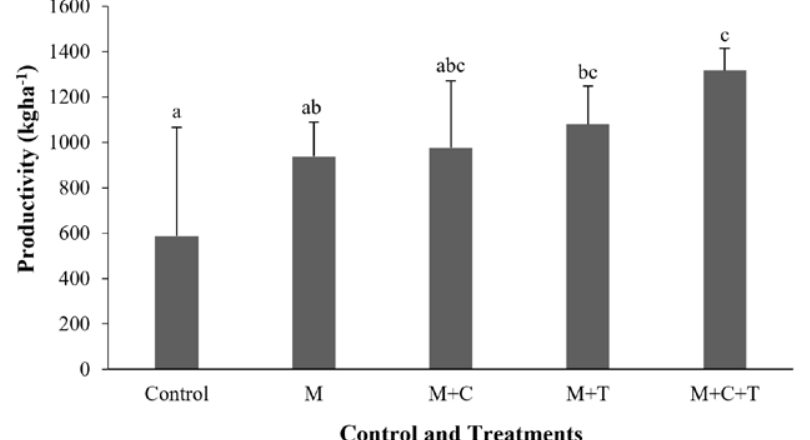
Fig. 2. Shallot productivity harvested at 63 days after treatment by mulch, mulch plus compost, mulch plus Trichoderma asperellum , and mulch plus compost and T. asperellum . M = mulch, C = compost, T = T. asperellum . Means of incidence at the same time, followed by the same letter are not significantly different according to DMRT (p ≤ 0.05). Vertical bars show standard errors of